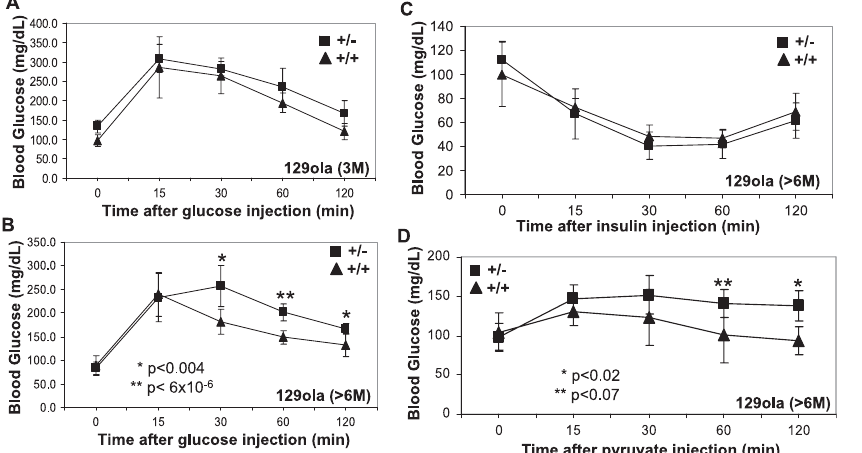
Figure 7. Metabolic Phenotypes of RanBP2 þ / (cid:1) Inbred Mice on High-Fat Diet (A) 3-mo-old inbred RanBP2 þ / (cid:1) mice ( n ¼ 5) have normal glucose clearance rates upon glucose challenge and overnight fasting. (B) In contrast, 6-mo-old inbred RanBP2 þ / (cid:1) mice ( n ¼ 5) have significantly decreased glucose clearance rates upon glucose challenge and overnight fasting. (C) Fasted 6- to 8-mo-old RanBP2 þ / þ and RanBP2 þ / (cid:1) mice have no differencein insulin-mediated glucose uptake as assayed by insulin tolerance test ( n ¼ 5). (D) Pyruvate tolerance test shows normal rise in glucose but decreased glucose clearance between inbred RanBP2 þ / þ and RanBP2 þ / (cid:1) mice ( n ¼ 5). DOI: 10.1371/journal.pgen.0020177.g007